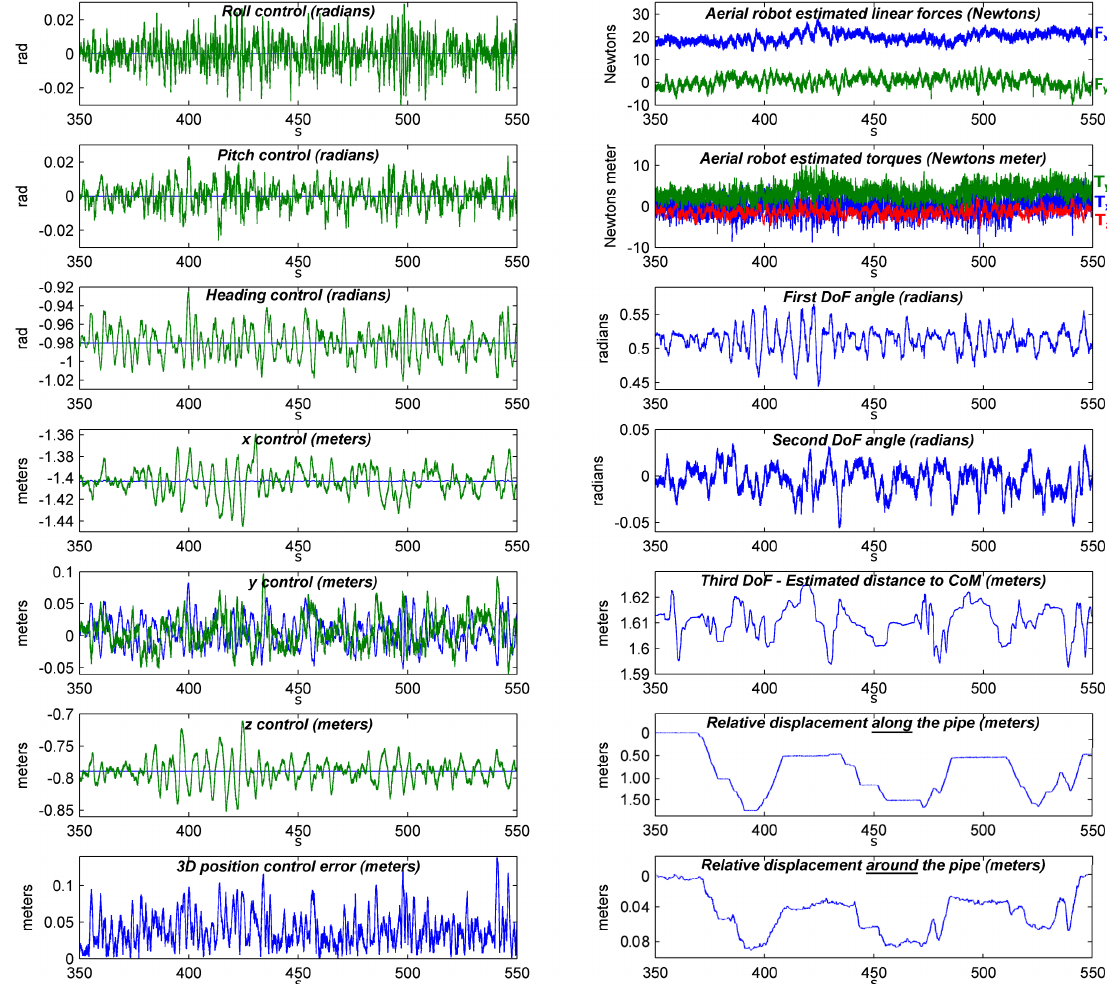
Figure 10. AeroX telemetry during contact-flight in one outdoor experiment performed in the outdoor testing setting near Seville in October 2018. The control responses for attitude and position (blue = reference, green = measured data) as well as the 3D estimated positioning error are shown at the left. The computed linear forces, torques, values of the first joint variables of the robotic contact device are plotted at the right. Linear force F x is in blue while F y is in green. In the torque graph, the torques around axes X , Y and Z are respectively in blue, green and red color. The relative displacement of the robotic end-effector along and around the pipe is presented at the